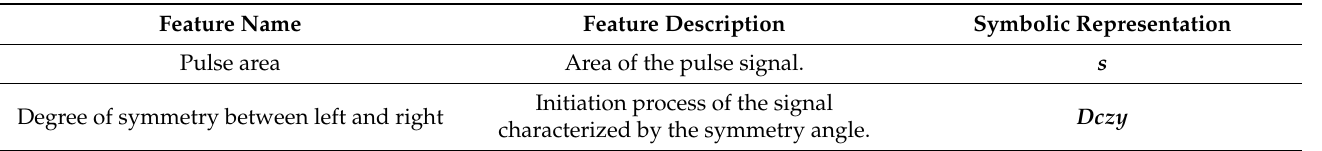
Table 3. Detailed description of loose particle